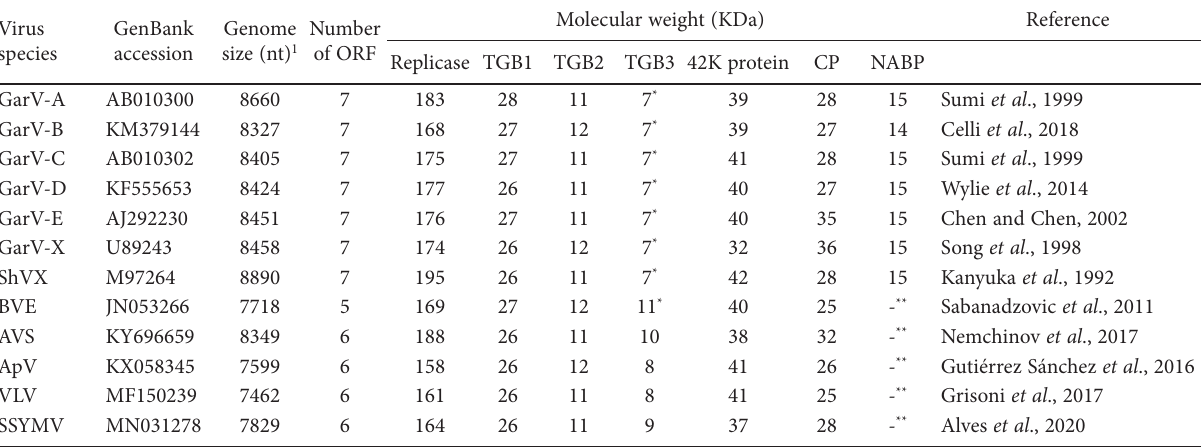
Table 1. Genome size, number and molecular weight of proteins encoded by the genes of each Allexivirus . Virus species